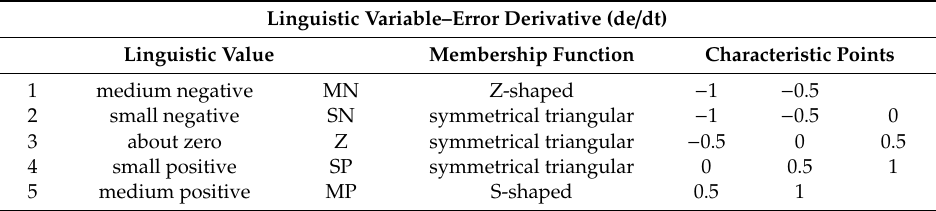
Table 10. The third version of the controller–error. Table 12. The third version of the controller–error derivative.